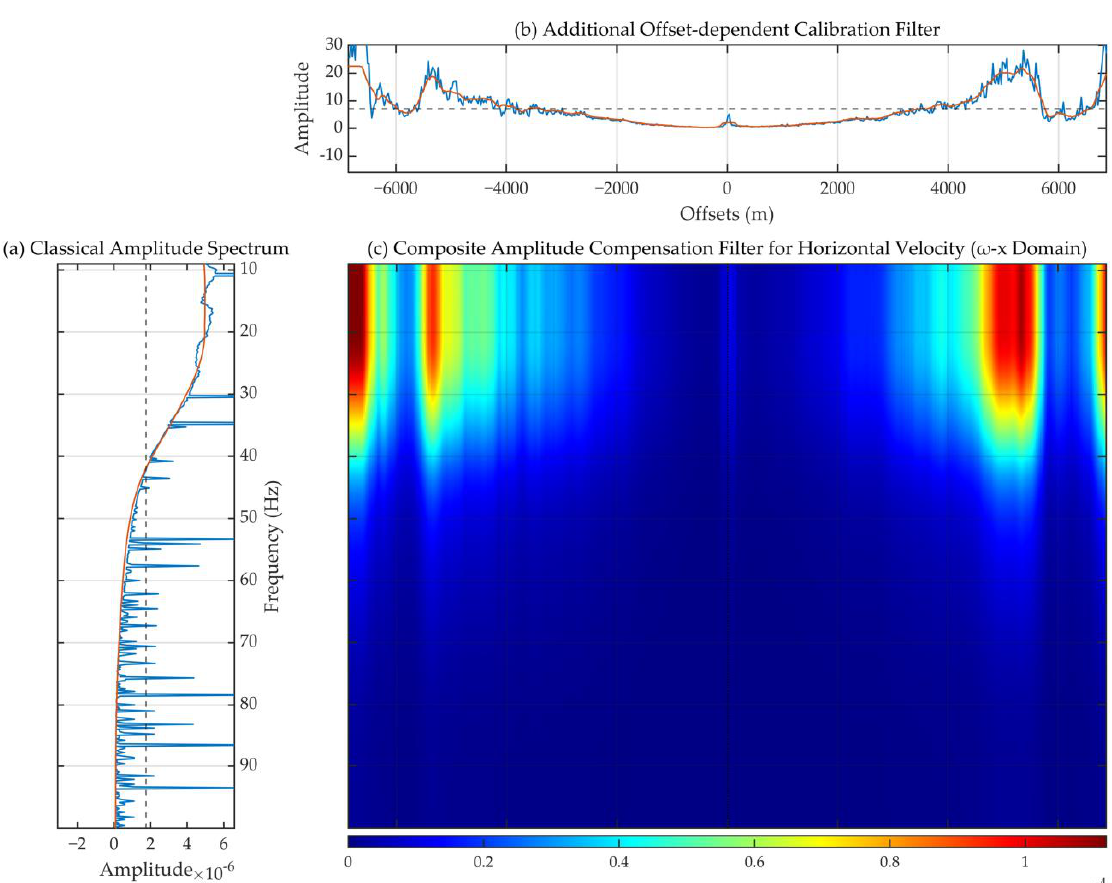
Figure 12. Demonstration of amplitude calibration for horizontal particle velocity data. ( a ) The classical-type frequency-dependent amplitude calibration filter optimized following traditional methods. ( b ) The additional calibration along the offset axis introduced after applying classical calibration by our novel method. ( c ) The composite amplitude compensation filter (i.e., the full amplitude spectrum of composite calibration filter) for the horizontal velocity component. Blue curve — optimized operator, orange curves — calculated curve.